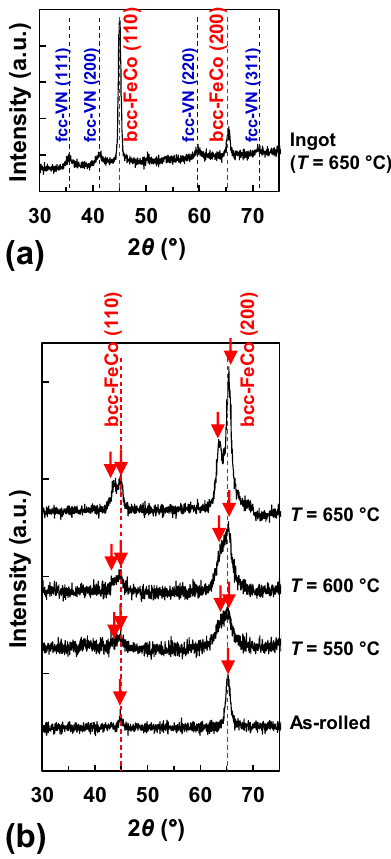
Figure 4. Out-of-plane XRD ( θ ‒ 2 θ ) patterns of ( a ) Fe–Co–V–N ingot nitrided at T = 650 °C and ( b ) Fe–Co–V foil (as-rolled) and Fe–Co–V–N foils nitrided at 550 °C ≤ T ≤ 650